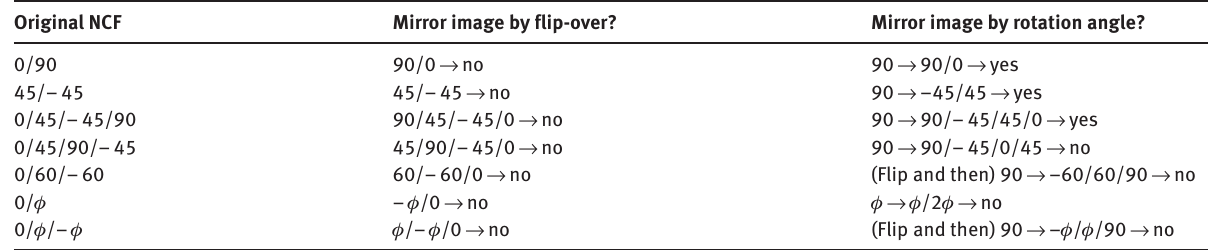
Table 3: Examples of NCF configurations in the view of mirror image possibilities by basic lay-up practices. Original NCF Mirror image by flip-over? Mirror image by rotation angle?